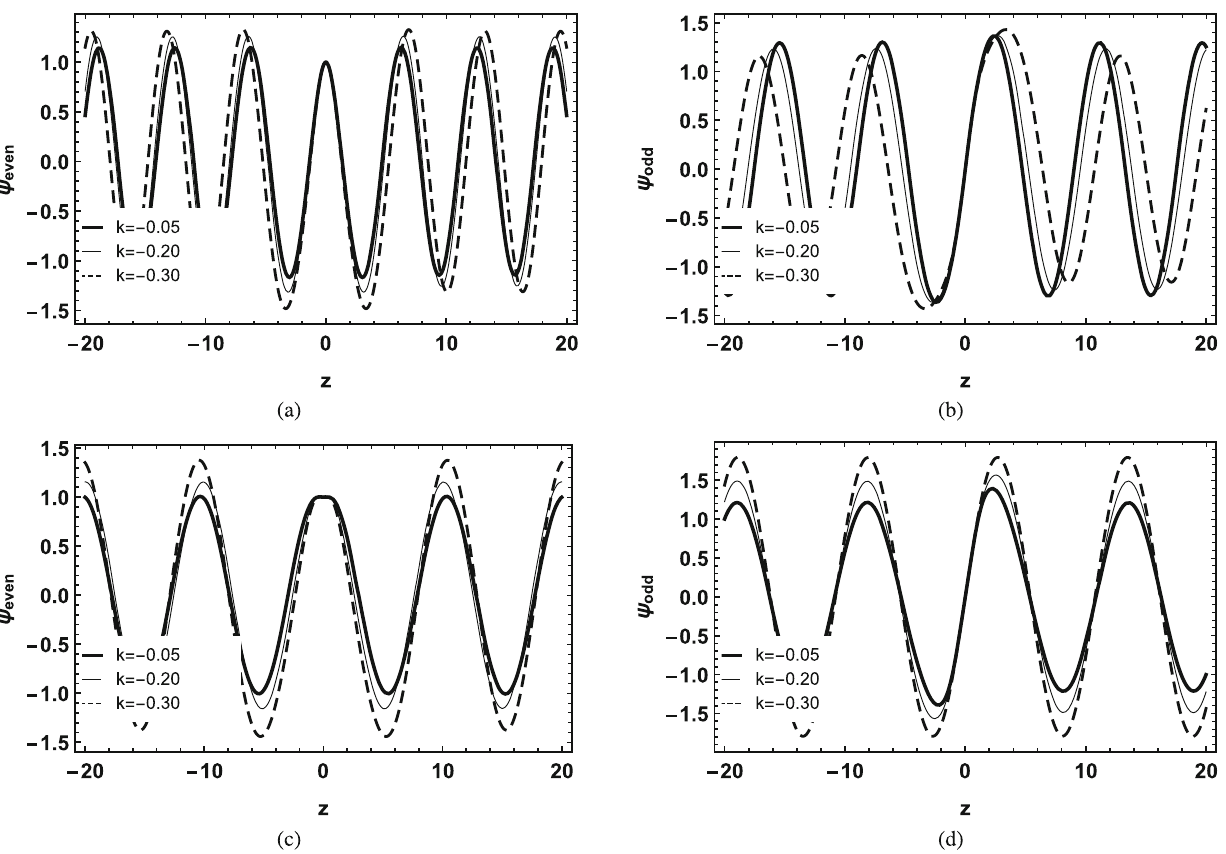
Fig. 8 The behavior of massive modes for G 1 (φ) , with n = 2, b = 4 and p = λ = 1. To the Gauge field, a ψ e v en with m = 1 . 001. b ψ odd with